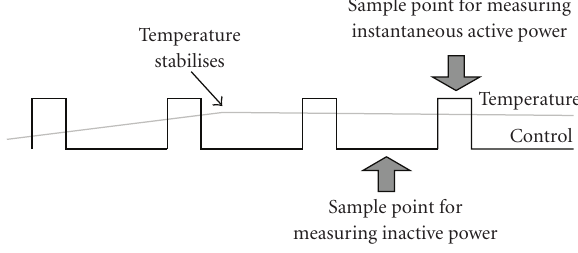
Figure 2: Depiction of power measurement sample points relative to